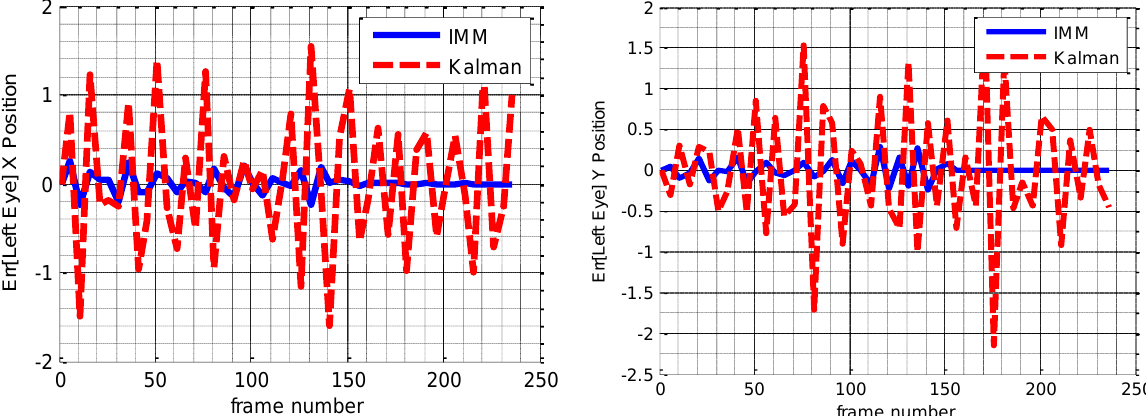
Figure 10. The error of left eye estimation of position